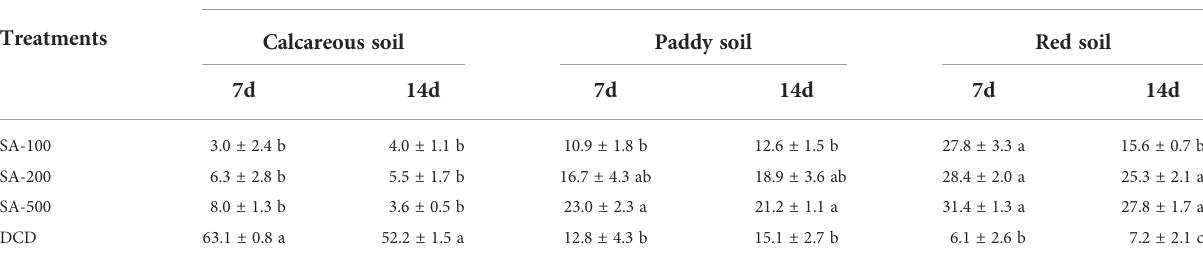
TABLE 2 Nitri fi cation inhibitory ef fi cacy (%) by SA and DCD treatments among three agricultural soils at day 7 and day